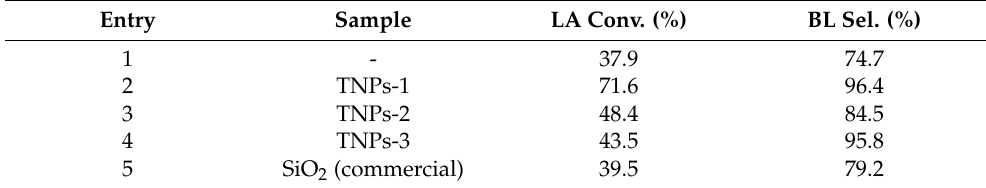
Figure 4. The NH 3 -TPD profiles of TNPs-1, TNPs-2, and TNPs-3.